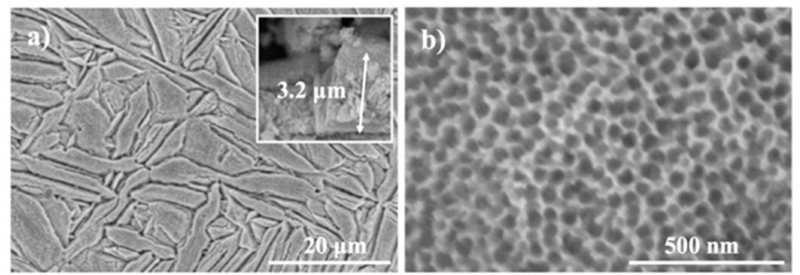
Figure 1. Morphology of nanochannels on TiZr substrates: ( a ) low magnification top view and